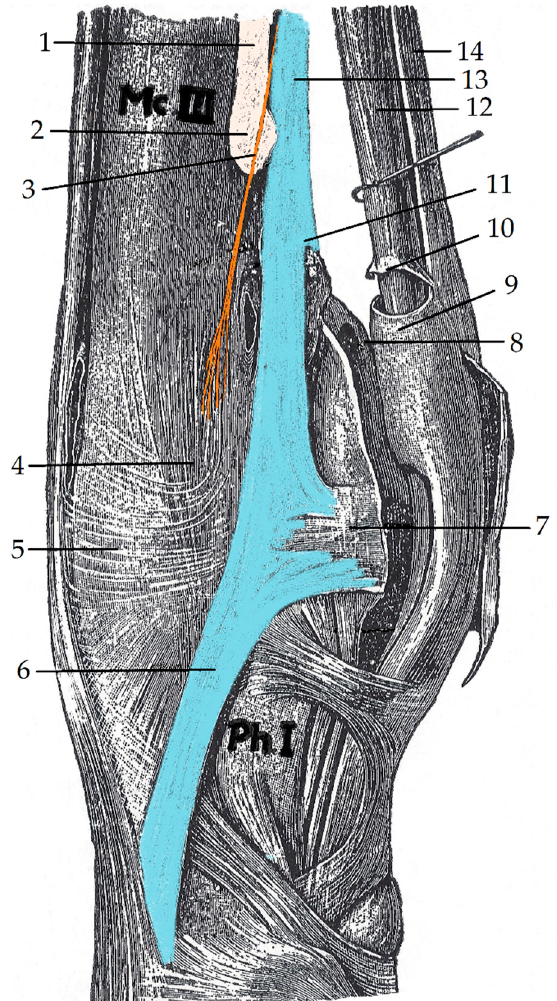
Figure 1. The medial view of the metacarpophalangeal joint in the equine right foreleg. The metacarpal II and its distal nodule (beige) and rudimentary tendon of the interosseous muscle II (orange) are noted. The medial branch of the interosseus III muscle, its bifurcation into medial and lateral branches of the interosseus III muscle have been depicted (blue). Adapted from Schmaltz 1911 [17]. Mc.III–metacarpal III; Ph.I–phalanx I; 1. metacarpal II (beige); 2. distal nodule metacarpal IV (beige); 3. rudimentary tendon of the interosseous muscle II (orange); 4. Medial collateral ligament of the metacarpophalangeal joint; 5. anterior fascia of the metacarpophalangeal joint; 6. medial branch of the interosseus III muscle (blue); 7. medial aspect of the collateral sesamoidean ligament; 8. intersesamoidean ligament; 9. manica flexorium; 10. proximal aspect of the digital tendon sheath; 11. bifurcation of the branches of the interosseus III muscle; 12. deep digital flexor tendon (DDFT); 13. interosseus III muscle; 14. superficial digital flexor tendon (SDFT).